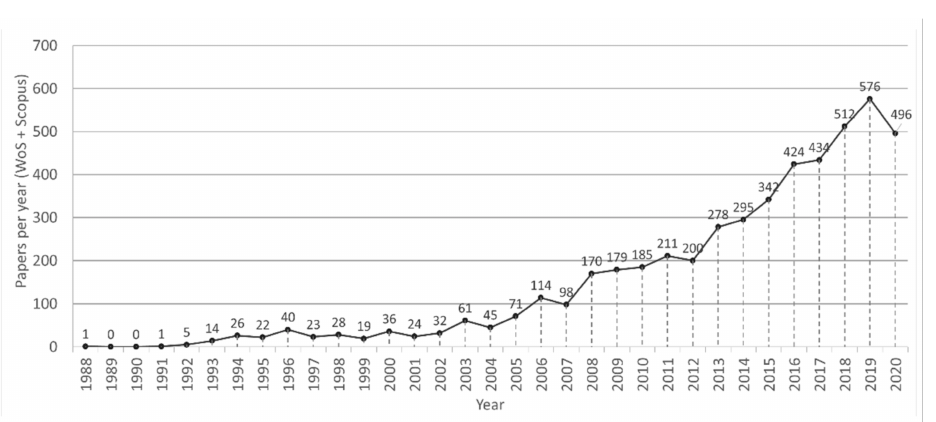
Figure 4. Evolution of papers per year that include “lean” in the title over the study period